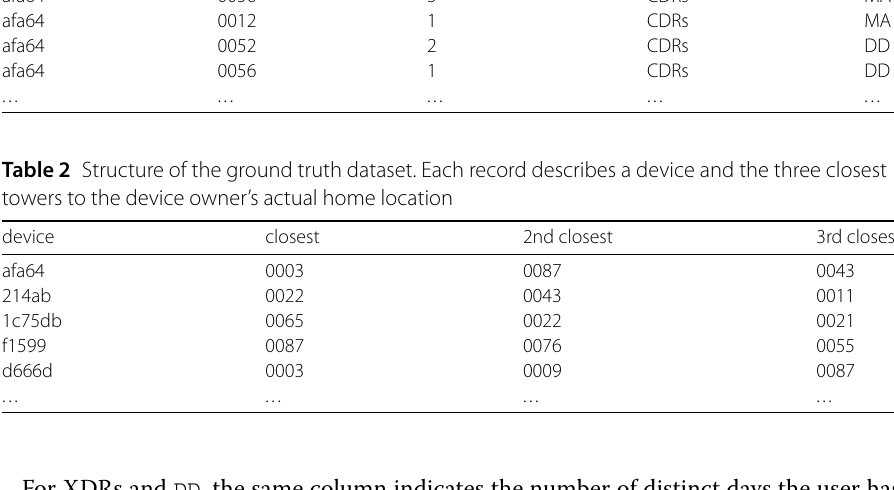
Table 1 Structure of the activity dataset. The records are sorted by device, stream, HDA, and activity device tower activity stream HDA